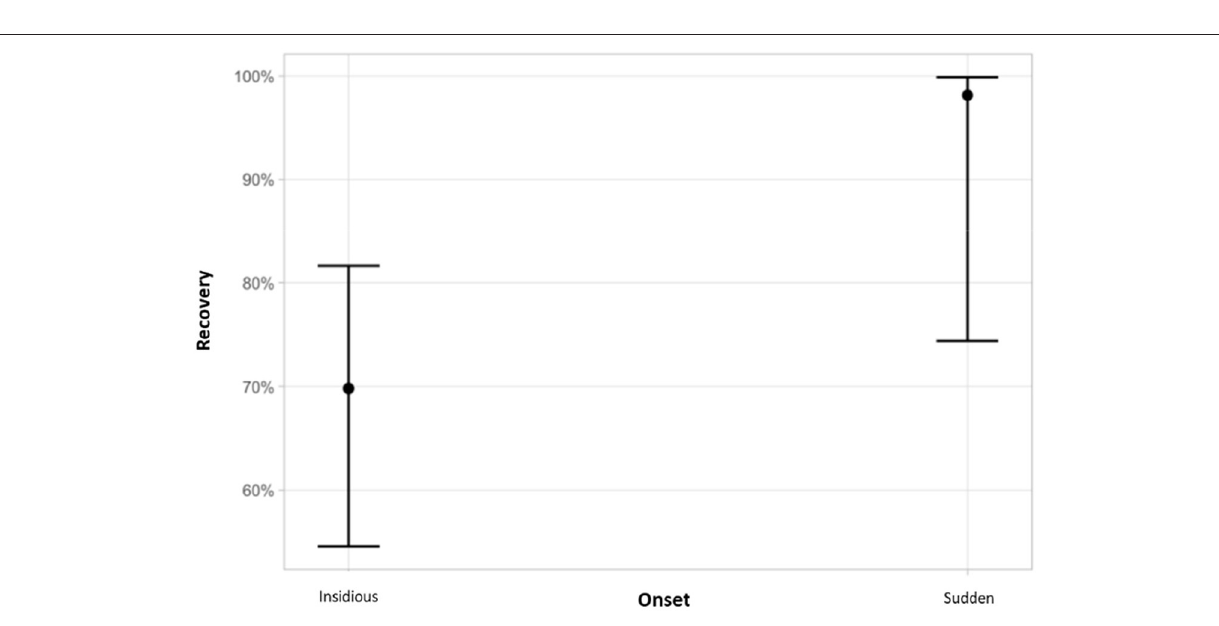
FIGURE 8 | Association between the type of onset and recovery. Cats with a sudden onset of clinical signs were more likely to recover ( p = 0.037). The y-axis shows probabilities of recovery predicted by the logistic regression. Graph displays estimated probabilities with 95% confidence